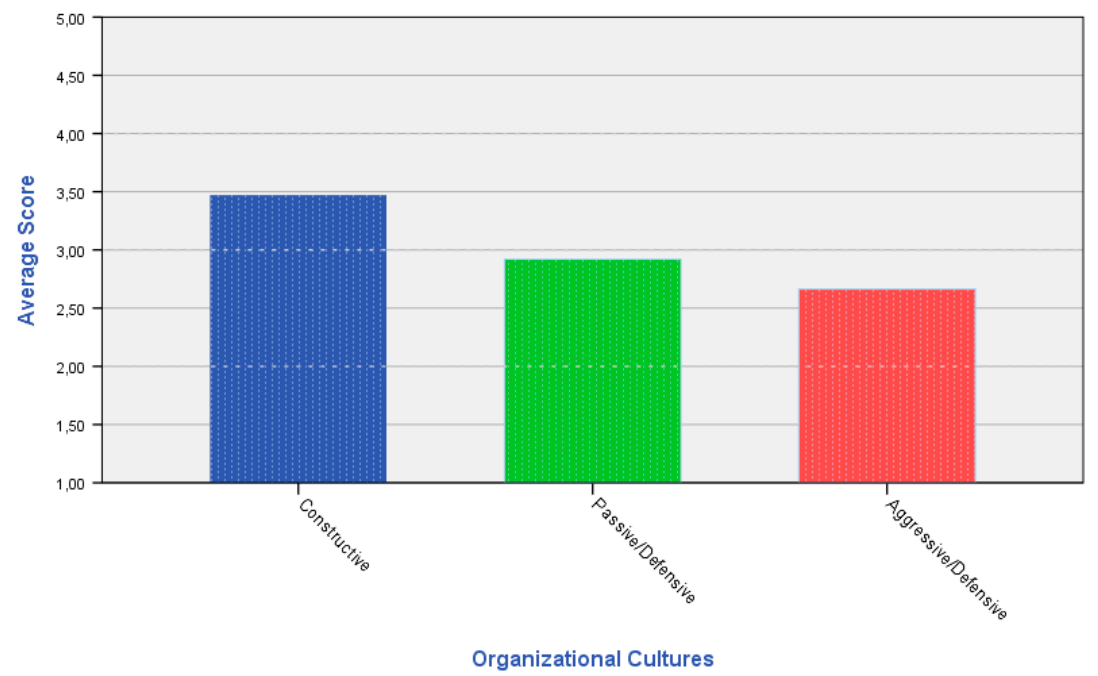
Figure 2. OCI Organizational culture